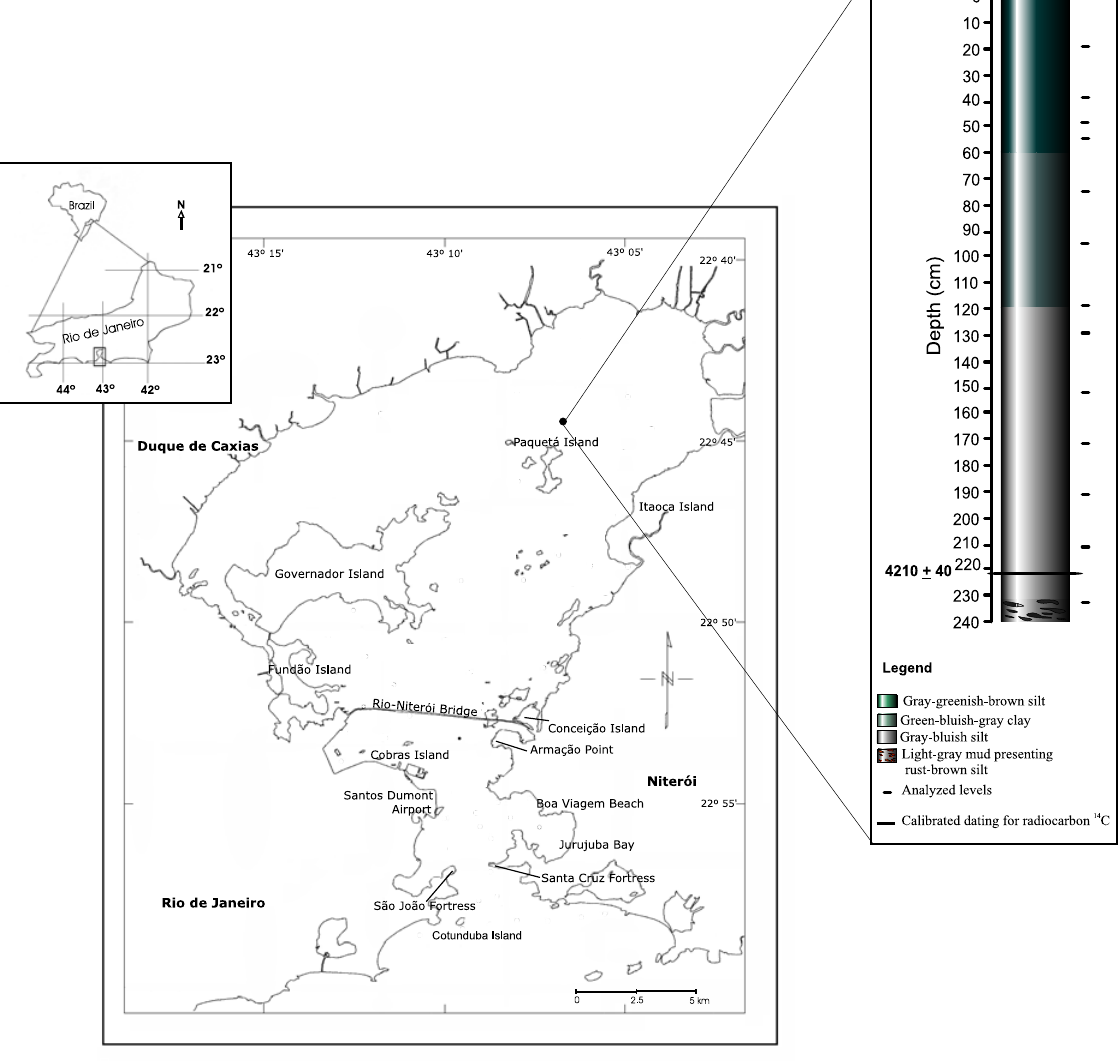
Fig. 1 – Map of the study area, showing the core in